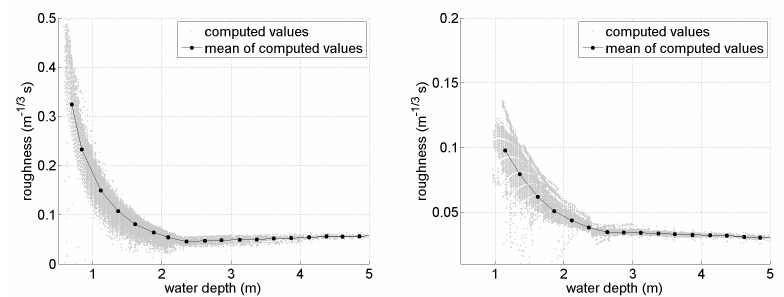
Figure 3. Estimated roughness coe¢ cients for the cross section of Incisa Fig. 3. Estimated roughness coefficients for the cross section of Incisa (left) and Nave di Rosano (right) in the river Arno. The variability of (left) and Nave di Rosano (right) in the river Arno. The variability of the the roughness coefficient tends to vanish with increasing water roughness coe¢ cient tends to vanish with increasing water depths.